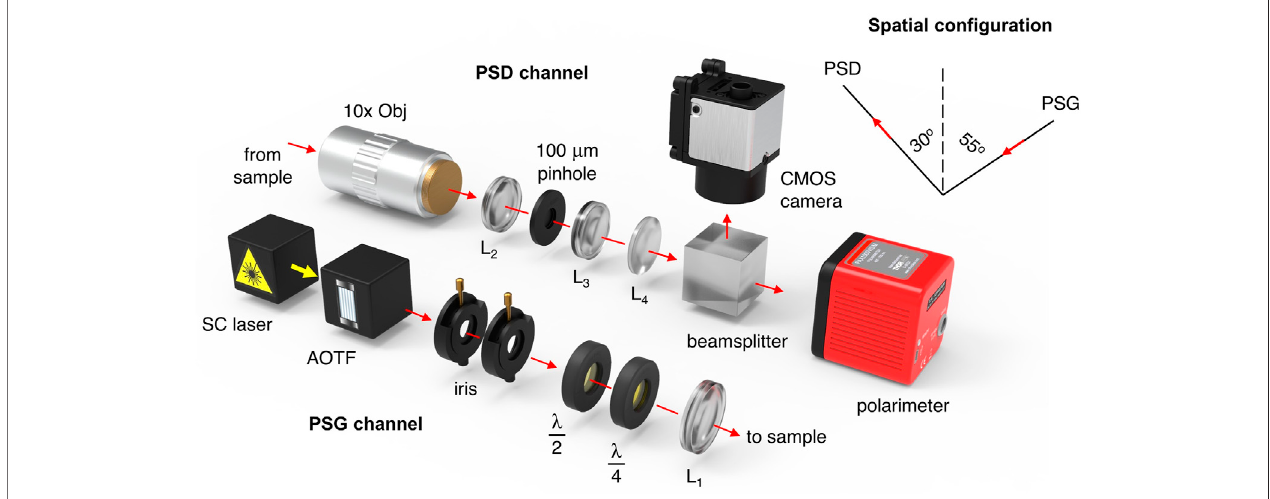
FIGURE 1 | Schematic representation of the experimental setup. Reprinted with permission from [26] © The Optical Society (Optica Publishing Group).